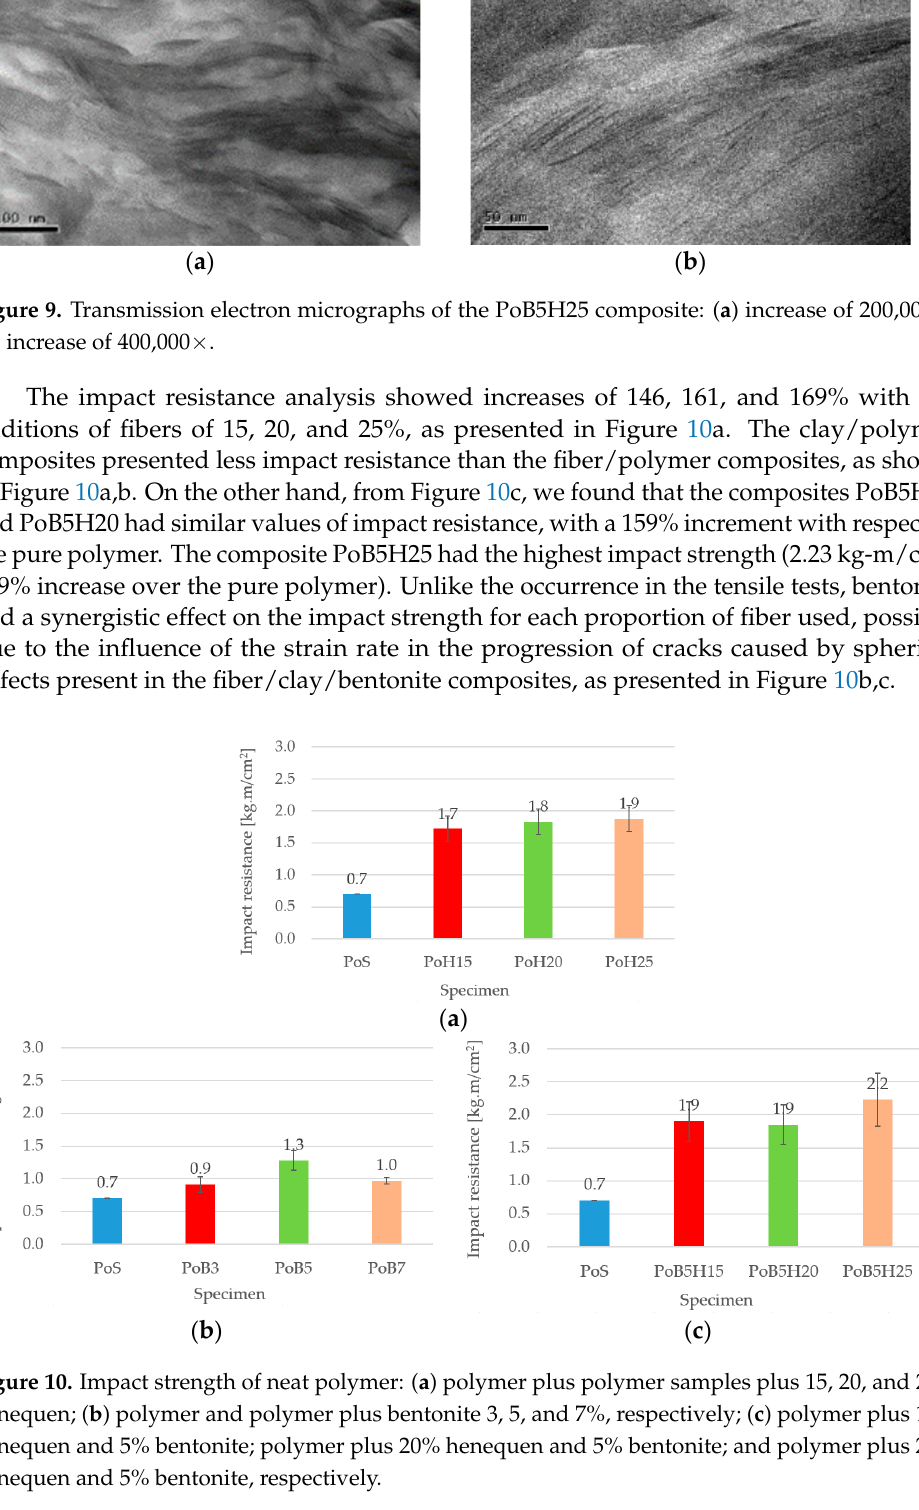
( c ) Figure 8. Micrographs of composites polymer/fiber/5% bentonite: ( a ) an amount of 15% fiber, bar corresponds to 100 μ m; ( b ) 20% fiber, bar corresponds to 200 μ m; and ( c ) 25% fiber, bar corresponds to 500 μ m. Figure 9 shows the transmission electron micrographs of the composite containing 25% fiber and 5%, bentonite (PoB5H25). Observed in Figure 9a are regions where the clay